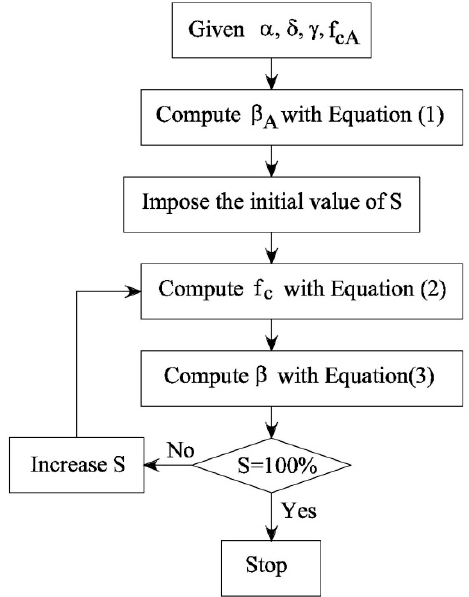
Figure 2. The procedure used to obtain the functions f c - S and β - S .